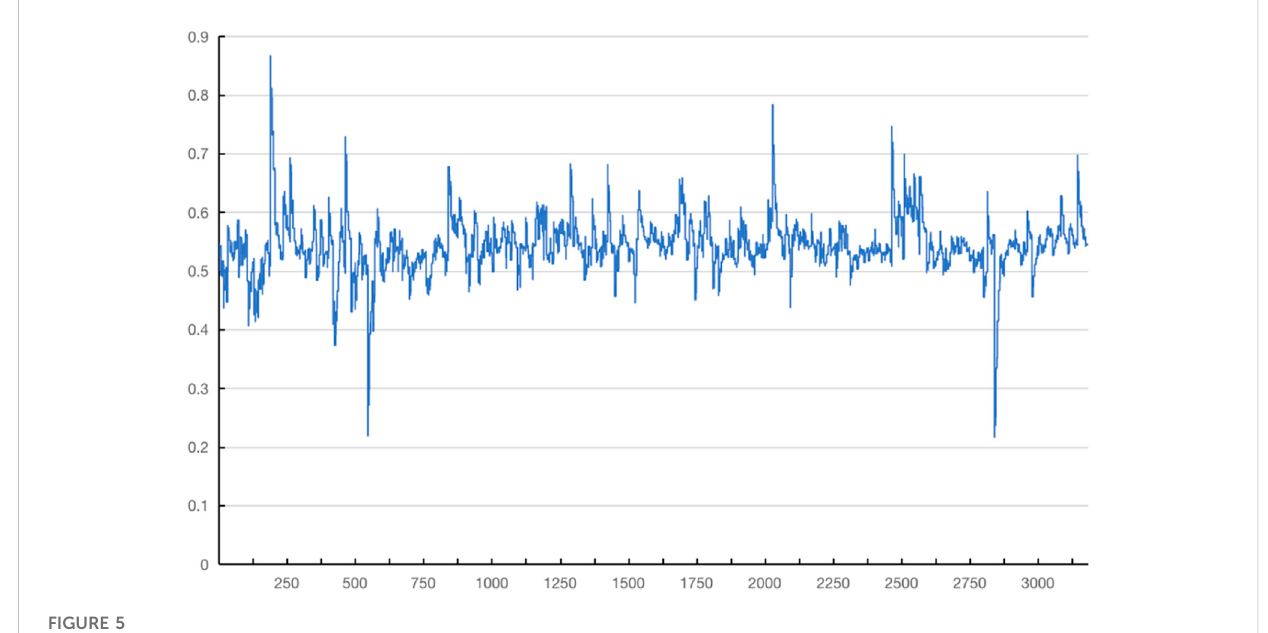
FIGURE 5 The dynamic correlation coef fi cient between Dgr35 and